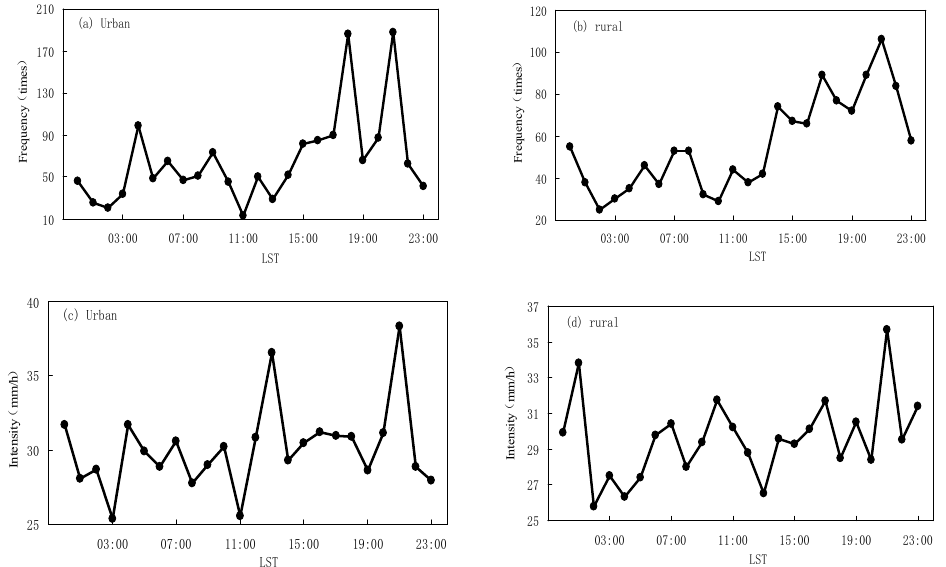
Figure 6. Diurnal variations of regional-averaged ExHP ( a , b ) frequency and ( c , d ) intensity at urban and rural stations in Shenyang.